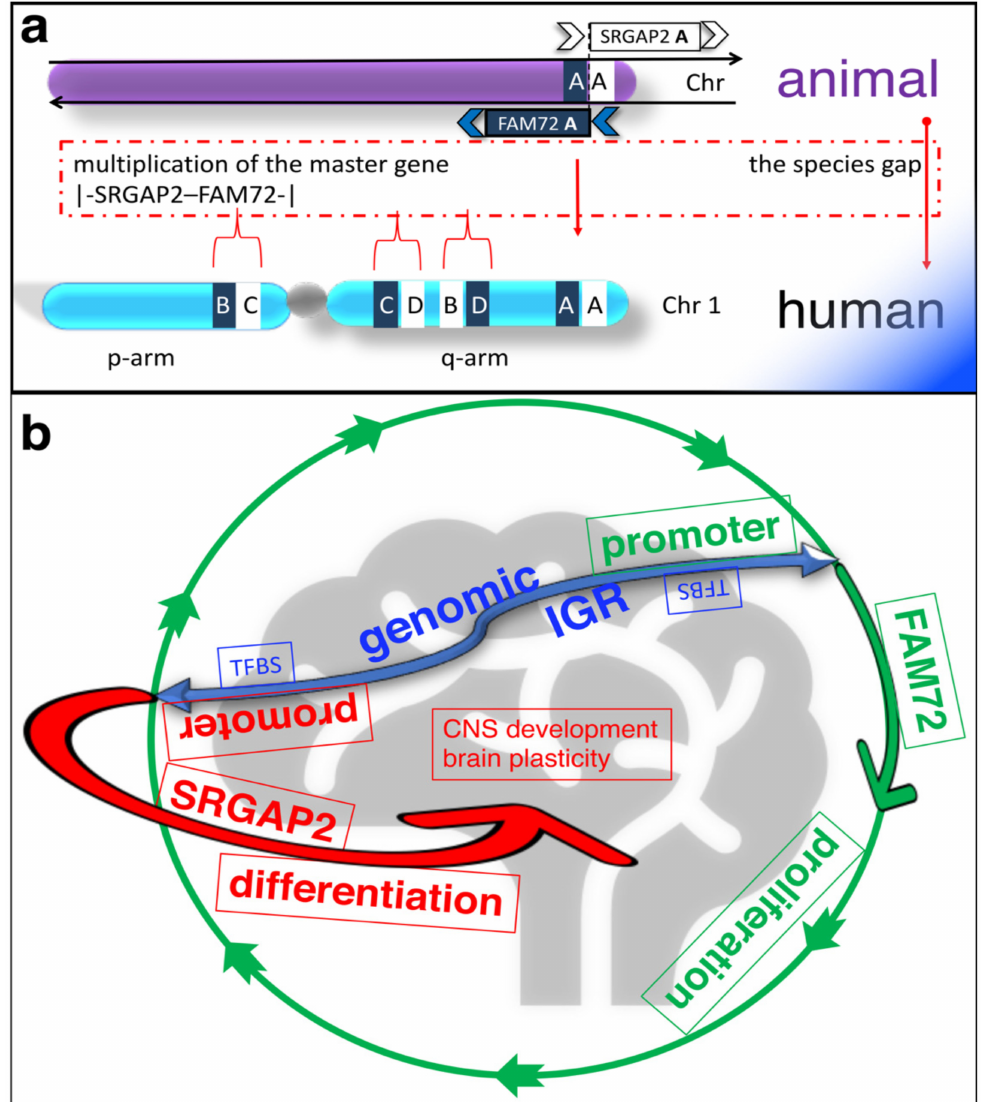
Figure 1. Overview scheme of the |-SRGAP2–FAM72-| master gene expression across the phylogenetic tree. ( a ) While humans express four master genes on chr 1, all other notochord containing vertebrates carry only one such master gene; other species do not show any such master gene, and thus far, no species have been found that show two or three such master genes. FAM72 shows four exons (149 amino acids (aa)), SRGAP2 is composed of 22 exons (1071 aa), and both sub-genes are separated by a 4-kbp intergenic region (IGR). The four paralogous gene pairs A–D are located on opposite strands from one another [1,2,5]. ( b ) Simplified divergent gene transcription paradigm scheme of the novel pivotal |-SRGAP2–FAM72-| master gene in the brain. The |-SRGAP2–FAM72-| master gene resides within a nucleosome-depleted region with the IGR (blue), containing potential transcription factor (TF)-binding sites (BS) (TFBS) between the SRGAP2 (red) and FAM72 (green) genes indicated. Reverse-oriented SRGAP2 (red) and FAM72 (green) genes are expressed from opposite DNA strands [1,8]. The dual IGR promotor controls the two reverse-oriented reciprocal functional-dependent genes FAM72 and SRGAP2, respectively, located on opposite DNA strands. If FAM72 gene is activated by TFs, then the transcription of the SRGAP2 gene is activated until it is actively terminated early and vice versa for neuronal differentiation; accordingly, if FAM72 is in the ‘on’ modus, SRGAP2 is switched off and vice versa [8–11]. Through this mechanism, FAM72 maintains renewal and proliferation of a critical mass of NSCs during brain development while SRGAP2 promotes escape of the cell cycle fostering neuronal differentiation and brain plasticity [5,8]. This structure represents a novel paradigm for controlling the transcription of divergent genes in regulating NSC gene expression and may allow for novel therapeutic approaches to restore or improve higher cognitive functions and cure cancers (Figure